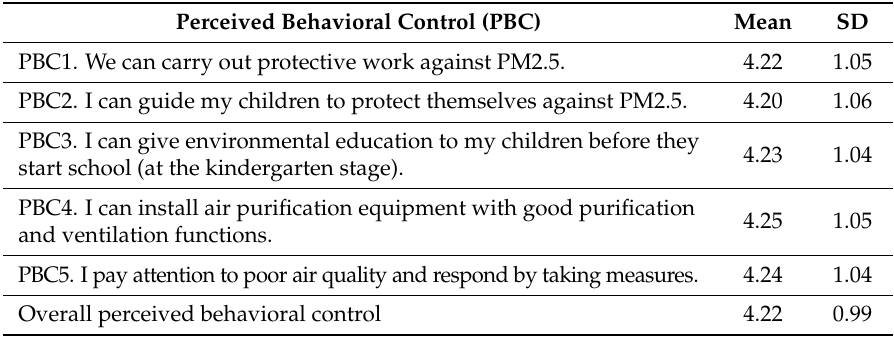
Table 8. Descriptive statistics for perceived behavioral control (PBC)-related items.